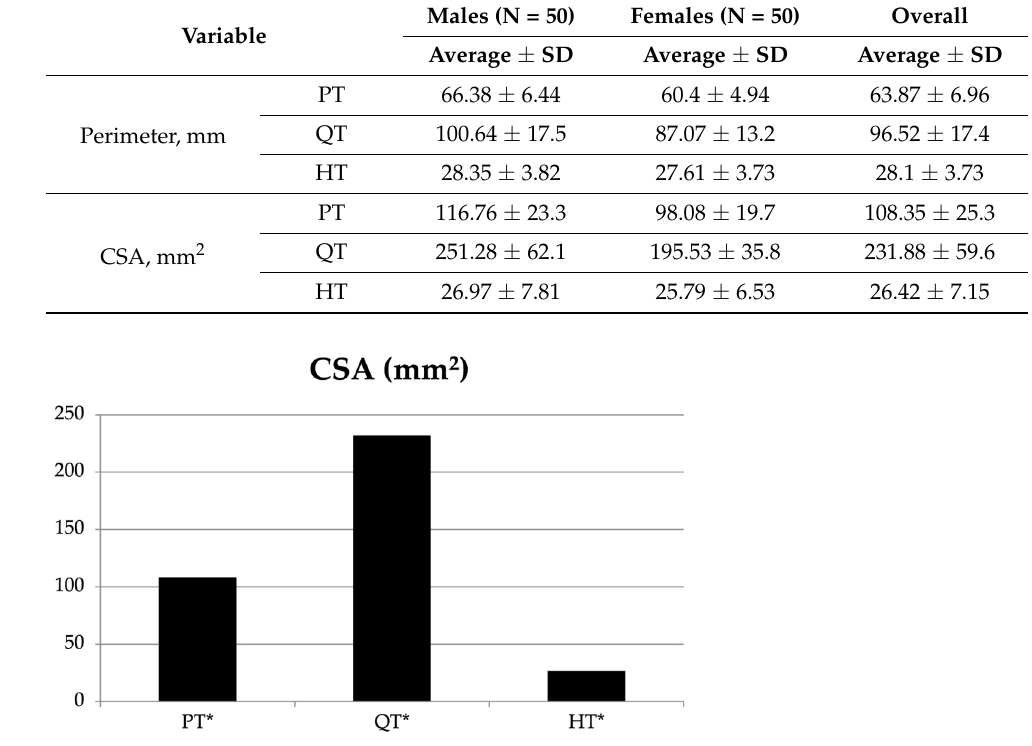
Figure 2. Representation of the cross ‐ sectional area (CSA) of the patellar tendon (PT), the quadriceps tendon (QT), and the hamstring tendons (HT). * Statistically significant.